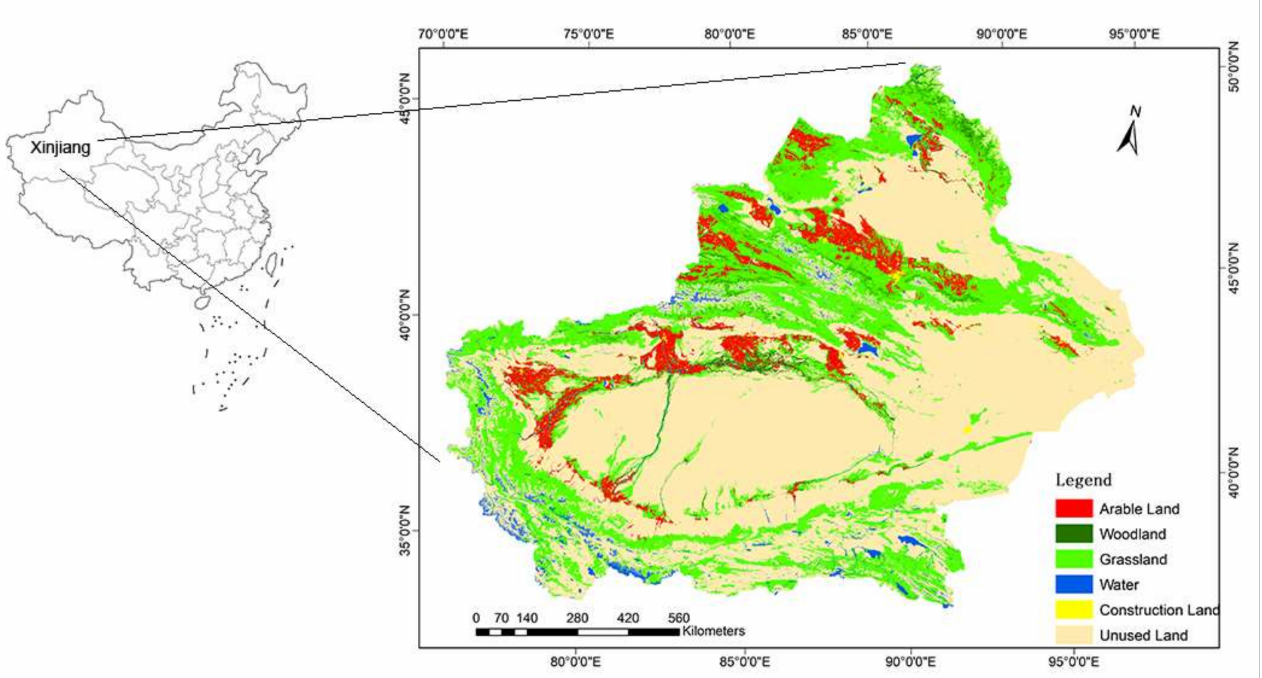
Figure 1. Location of Xinjiang in China and LULC in Xinjiang in 2019. Note: This map is based on the standard map of the XinS (2021) 023 downloaded from the Xinjiang Uygur Autonomous Region Geographic Information Public Service Platform.